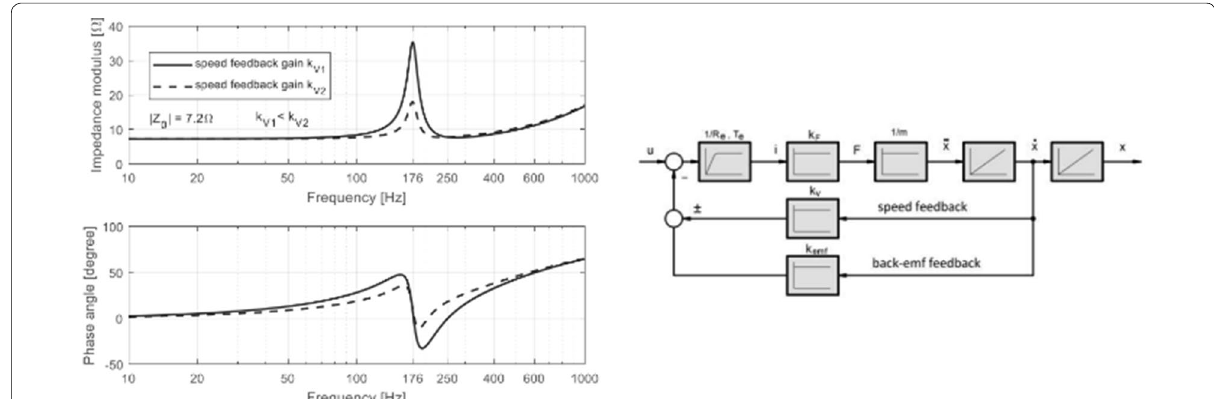
Figure 9 The influence of speed feedback on the equivalent electrical impedance